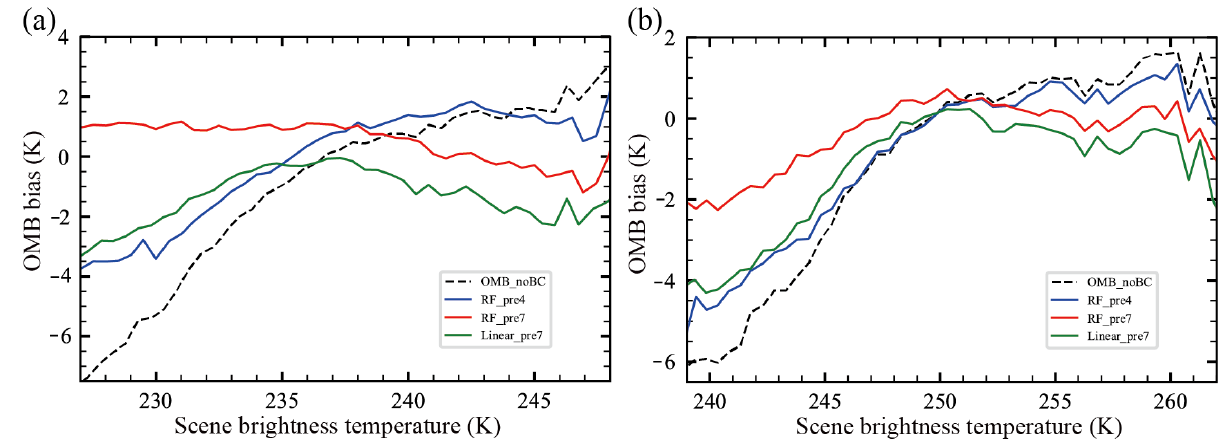
Figure 4. Variations in the biases of OMB (unit:K) with respect to the predictors of scene brightness temperature (unit: K) for AGRI ( a ) channel 9 and ( b ) channel 10 valid at 0600 UTC 19 July 2021.